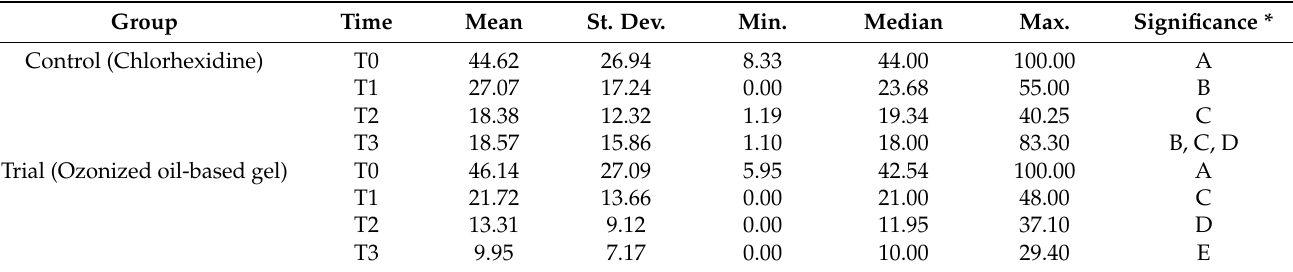
Table 6. Descriptive statistics of Bleeding on Probing (BoP).